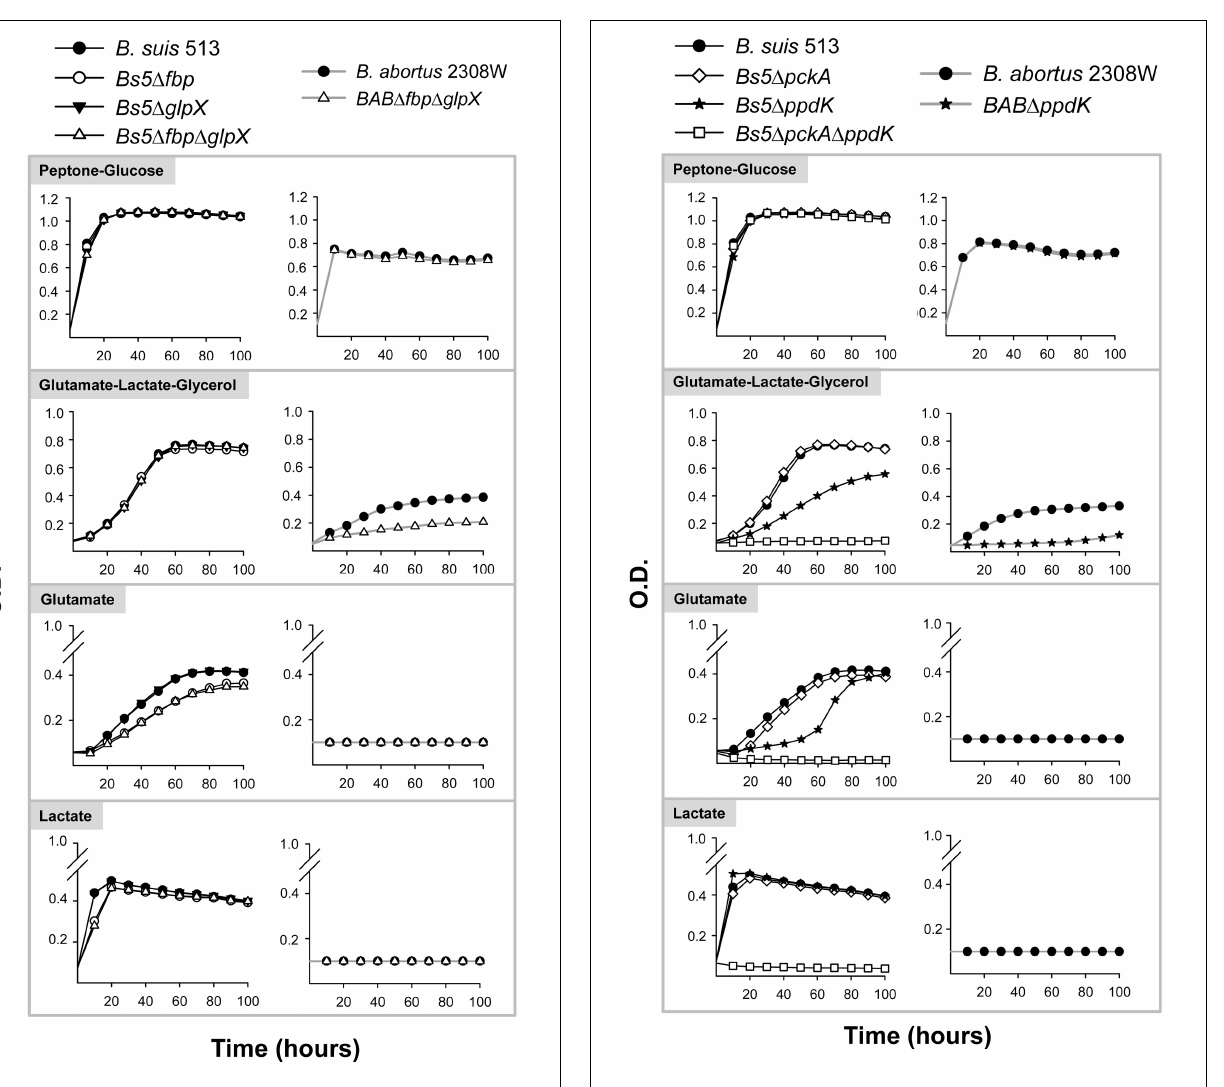
(strain CCM4915) BMI_I1020. Although in B. microti there is a second ORF annotated as mae (BMI_I149), its B. suis